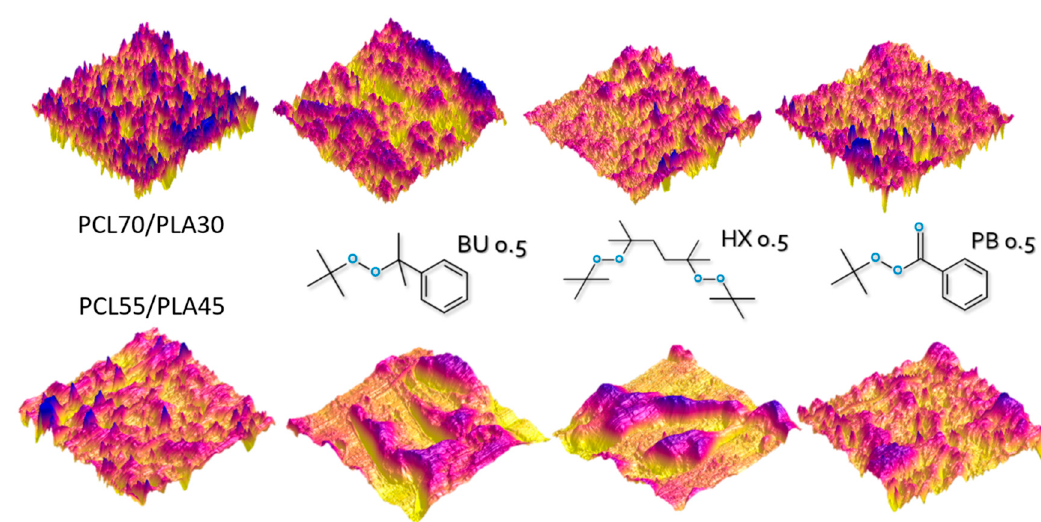
Figure 11. The effect of different types of organic peroxide on the morphology of PCL/PLA blends in the weight ratio of 55/45.